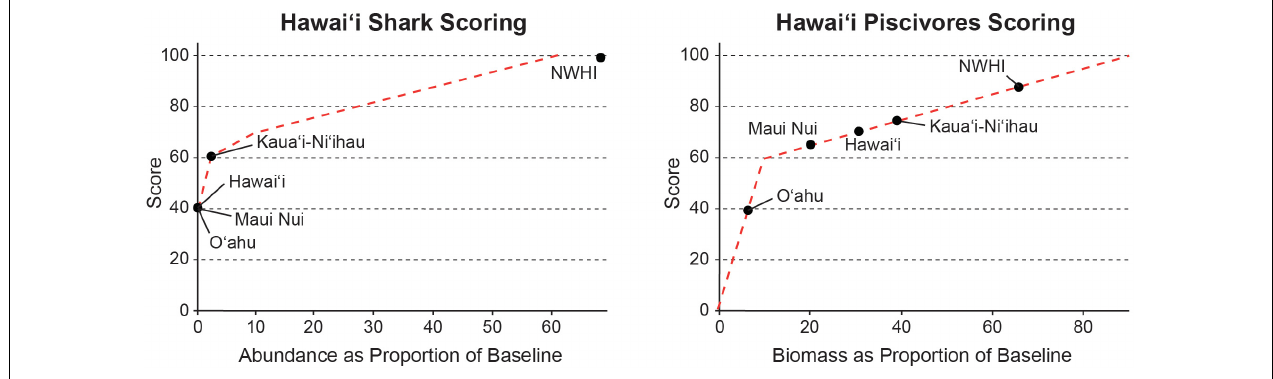
FIGURE 3 | Scoring plots for the Main Hawaiian Islands (O‘ahu, Maui Nui, Hawai‘i, and Kaua‘i-Ni‘ihau) and the Northwestern Hawaiian Islands (NWHI) for sharks (left) and other piscivores (right) adapted from Nadon et al.